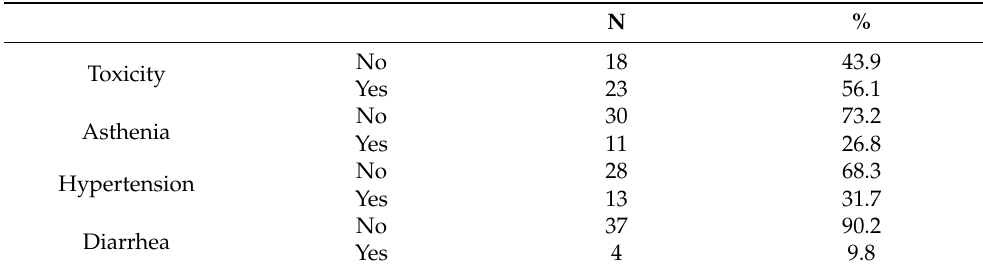
Table 4. Patients’ major regorafenib-associated toxicities. Principal toxicity events are listed, and the percentage of appearance is